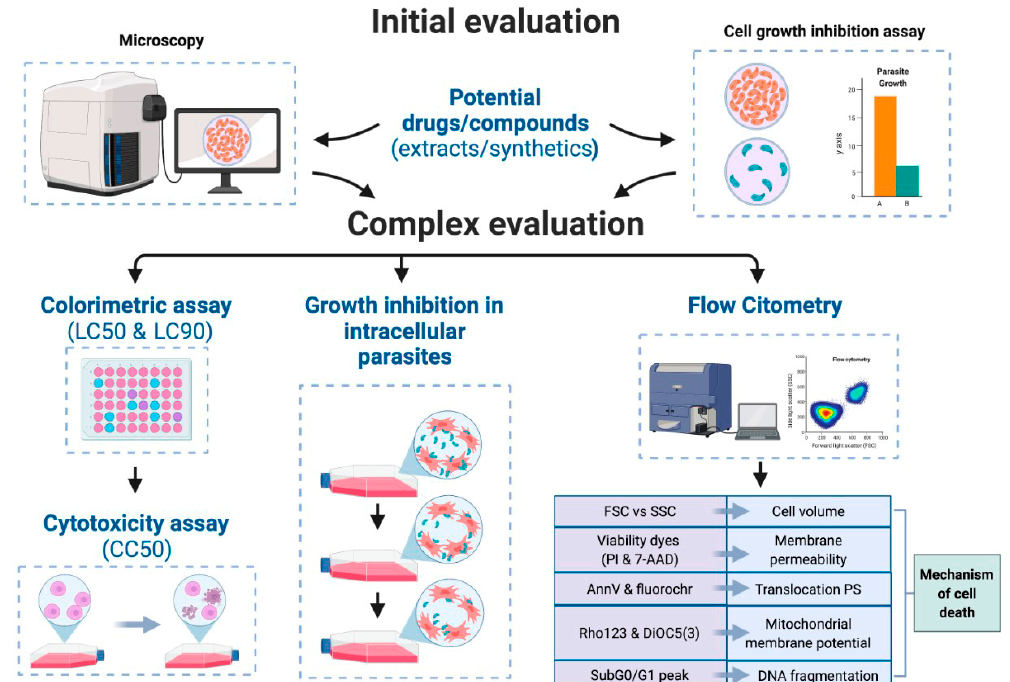
Figure 3. Process of in vitro evaluation for potential antiprotozoal activity; LC: Lethal concentration, CC50: 50% cytotoxicity concentration, FSC: Forward Scattered FSC, SSC: Side Scatter, PI: Propidium iodide, 7-AAD: 7-aminoactinomycin D, AnnV: Annexin V, PS: phosphatidylserine, Rho123: Rhoda- mine 123, DiOC5(3): 3,3 ′ - dipentyloxacarbocyanine iodide, SubG0 and G1: cell cycle phases. In Cell growth inhibition assay, A and B represent the untreated and treated samples of the assay.